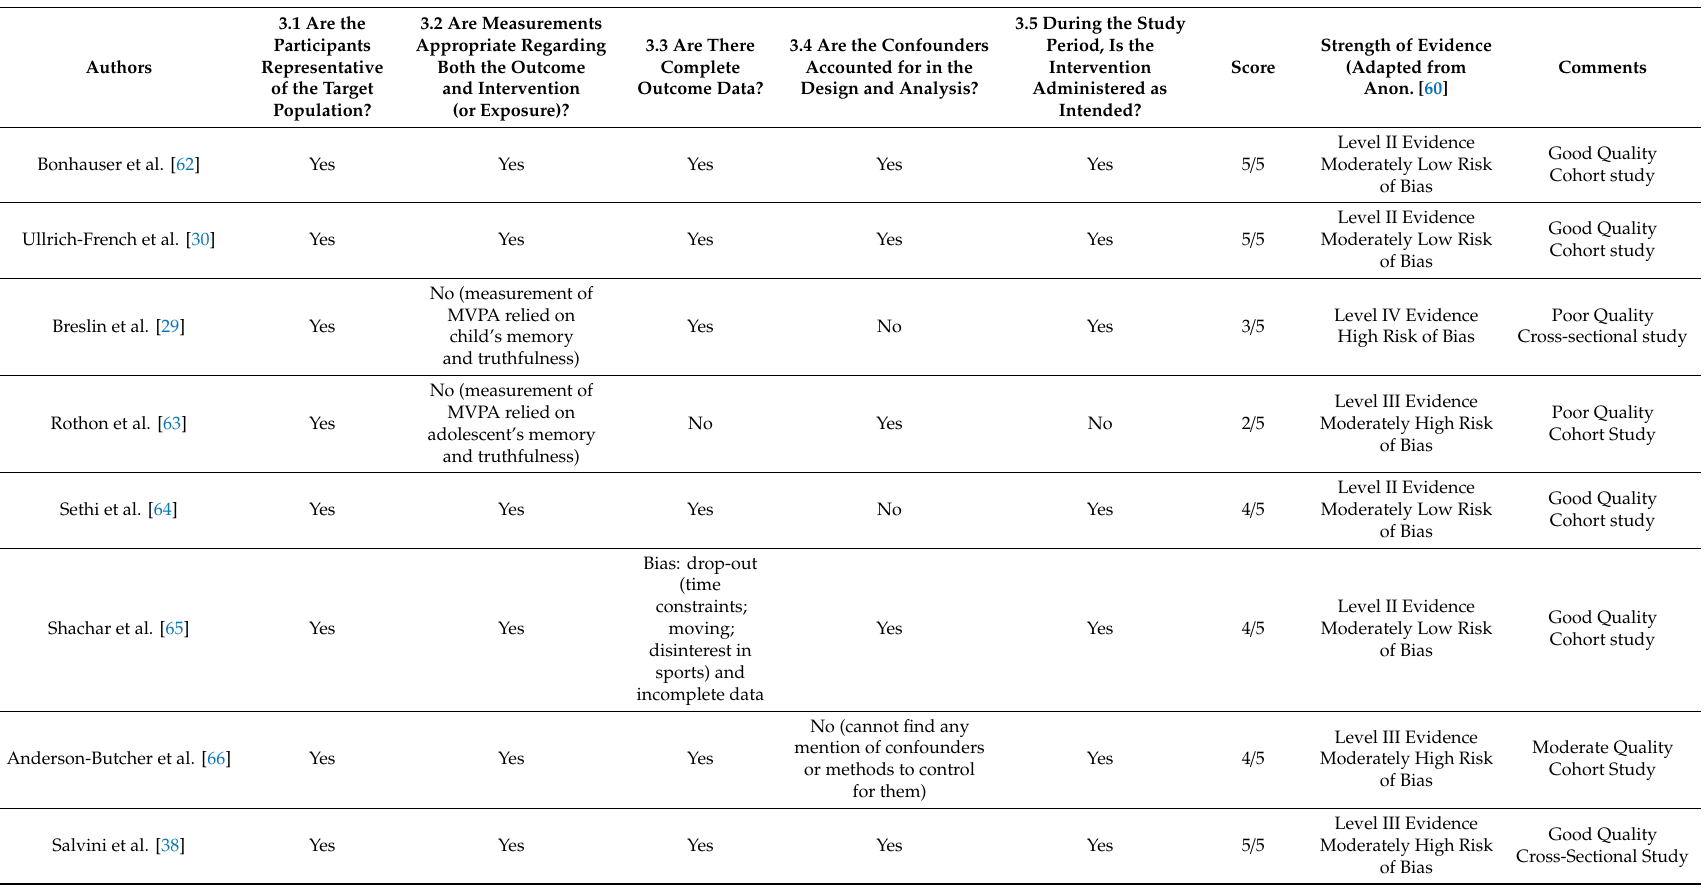
Table 4. Quality Assessment for Quantitative Non-Randomised studies using the MMAT